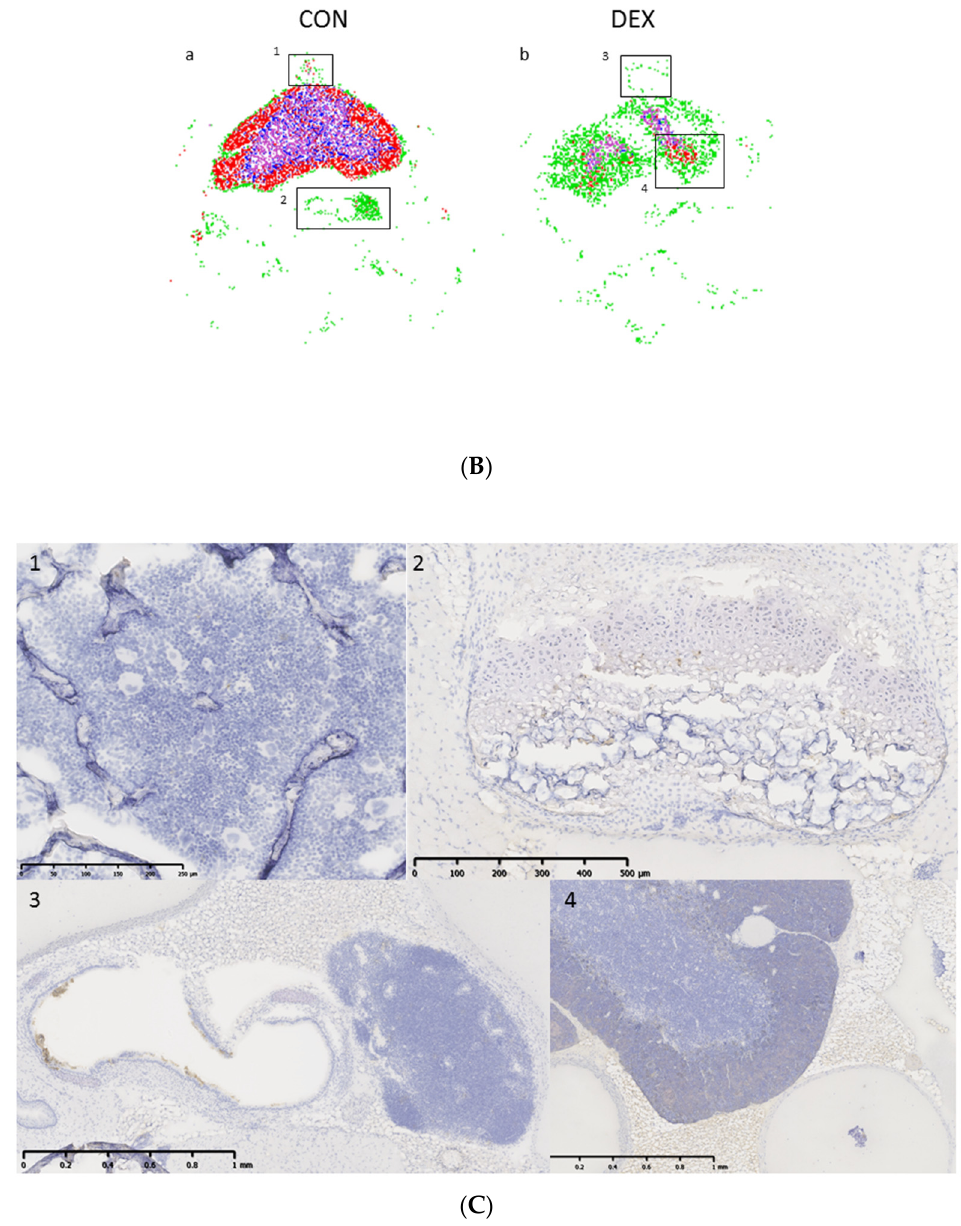
Figure 7. ( A ) UMAP-profiled metabolic status of the thymus. Four clusters were shown as green ( b ), red ( c ), blue ( d ), and purple ( e ). Four metabolomic profiles were merged with HE staining ( f ). In each panel, left-sided tissues were from control thymus and right-sided tissues were from DEX-treated mice. ( B ) Four UMAP profiles were merged against blank. ( C ) TUNEL staining of the squared areas in ( B ) were enlarged as ( 1 , 2 ) from control, ( 3 , 4 ) from DEX treated mouse. ( 1 , 2 ) from bone marrow and ( 3 ) from trachea and lymph node. ( 4 ) from cortex and medulla of the DEX-treated thymus.